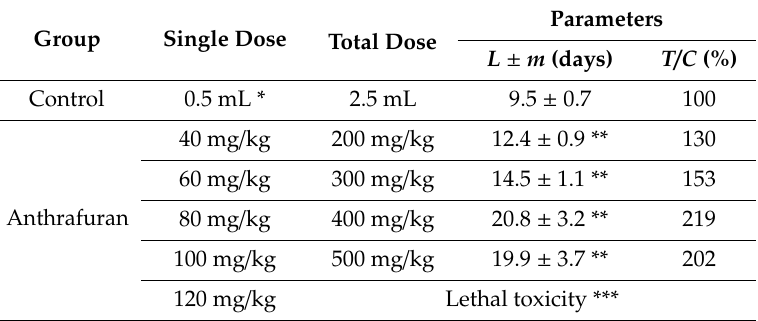
Table 1. Life span of mice bearing P388 leukemia after oral administration of anthrafuran for a five-day course (5 × 24 h).